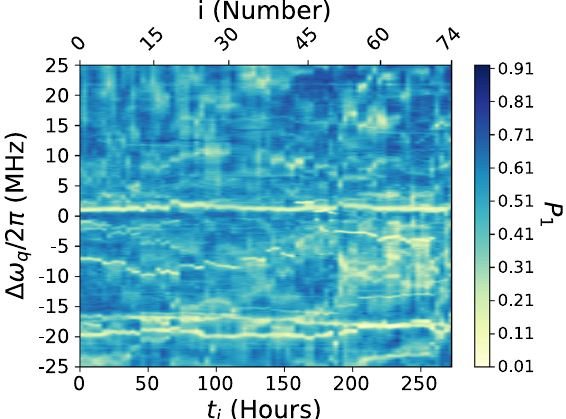
Fig. 4 Time dependence of energy relaxation spectroscopy. Time dependence of the energy relaxation spectroscopy for Q 15 using = ± 50 MHz and varying Ω Δ ω s s over 501 different j amplitude points, Ω s , j , to sweep Δ ω q ( Ω s , j ) in a positive or negative direction (see Eqn. (1)). The P 1 is measured at 50 μ